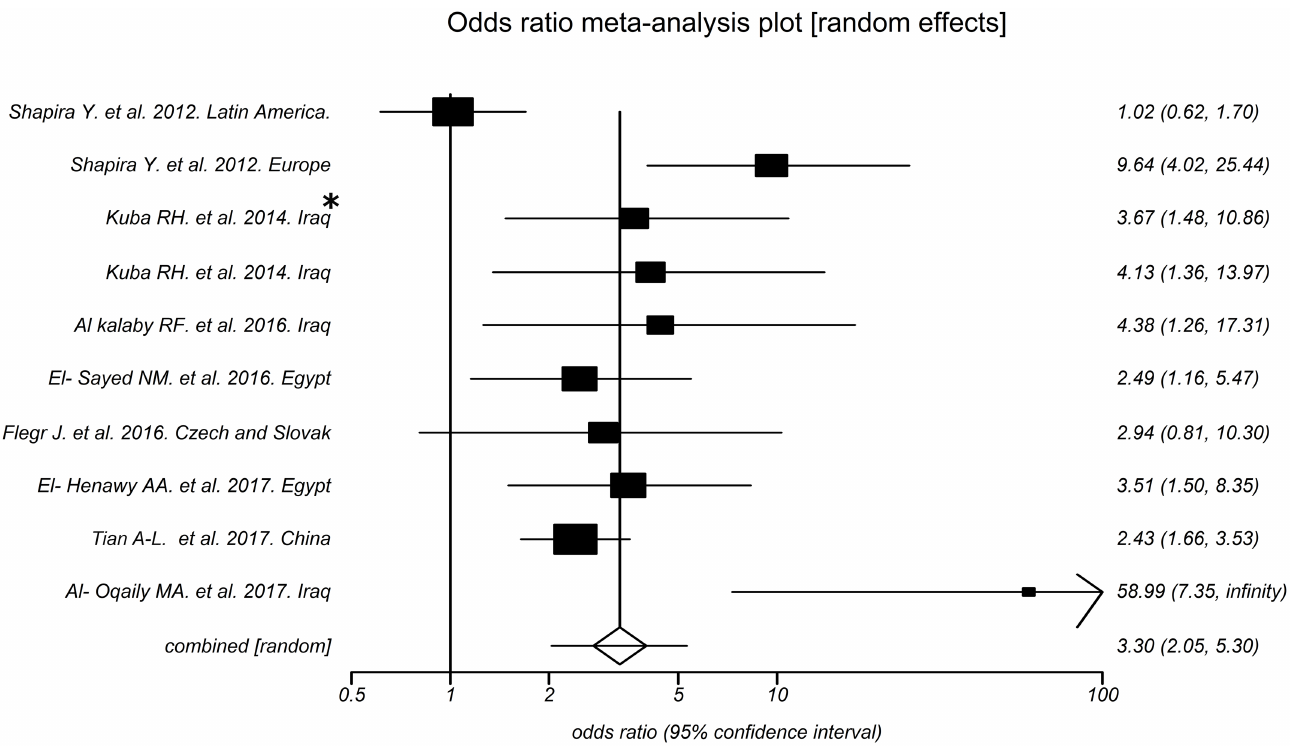
Fig 4. Forest plot of odds ratios for correlation between toxoplasmosis and rheumatoid arthritis. (cid:3) Patients under treatment.